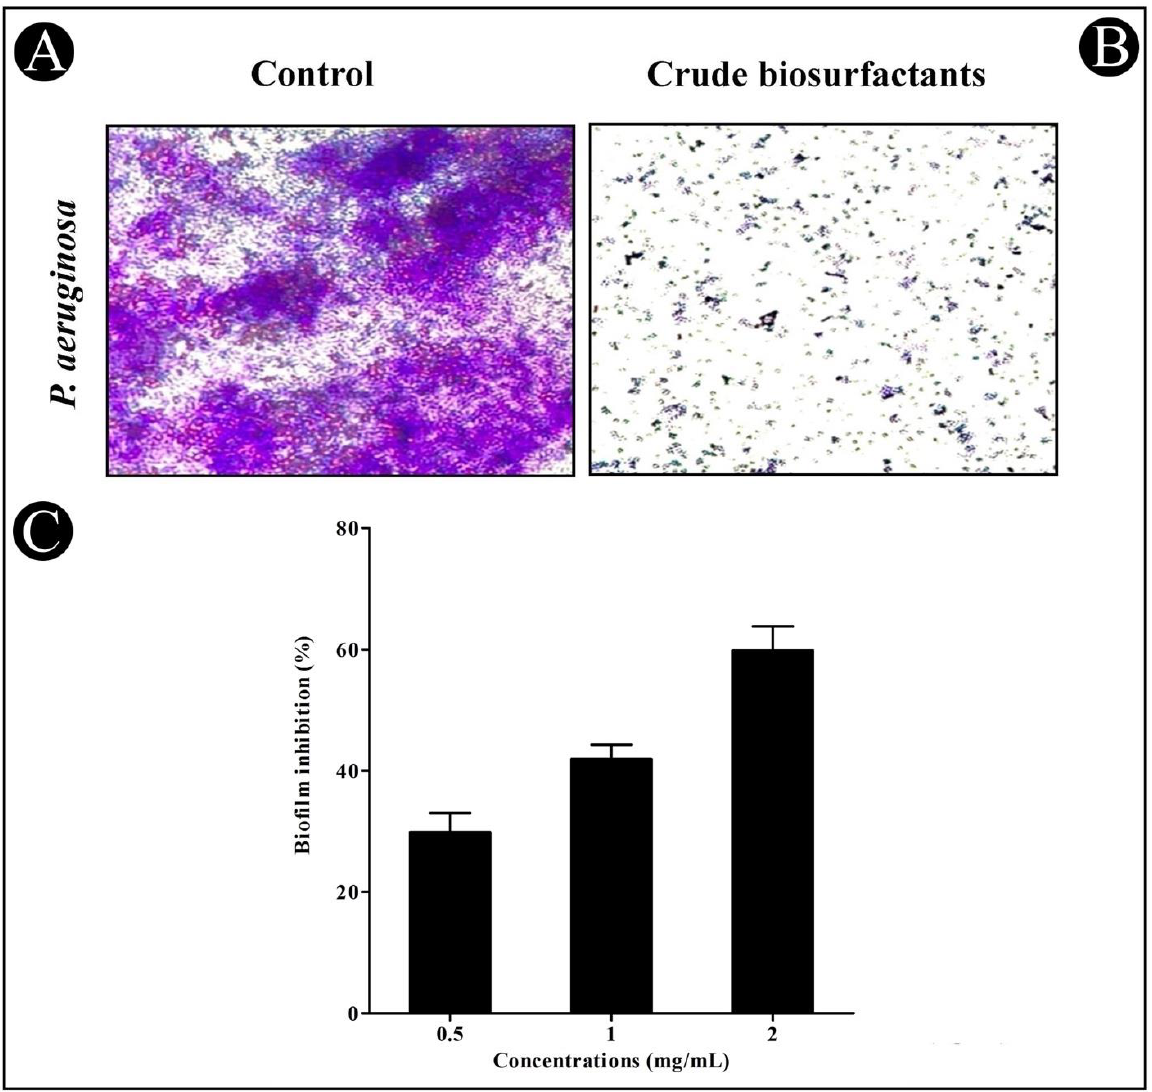
Figure 6. In situ light microscopy analysis of the biofilm inhibition and antibiofilm potential of the crude L. plantarum biosurfactant against P. aeruginosa . ( A ) The control shows biofilm formation. ( B ) The crude biosurfactant reduced the biofilm matrix at a concentration of 2.5 mg/mL. ( C ) The inhibition of the biofilm was detected by a UV – VIS spectrophotometer and presented as percentage inhibition (with respect to untreated control). Values are represented as mean ± SD of three independent experiments.